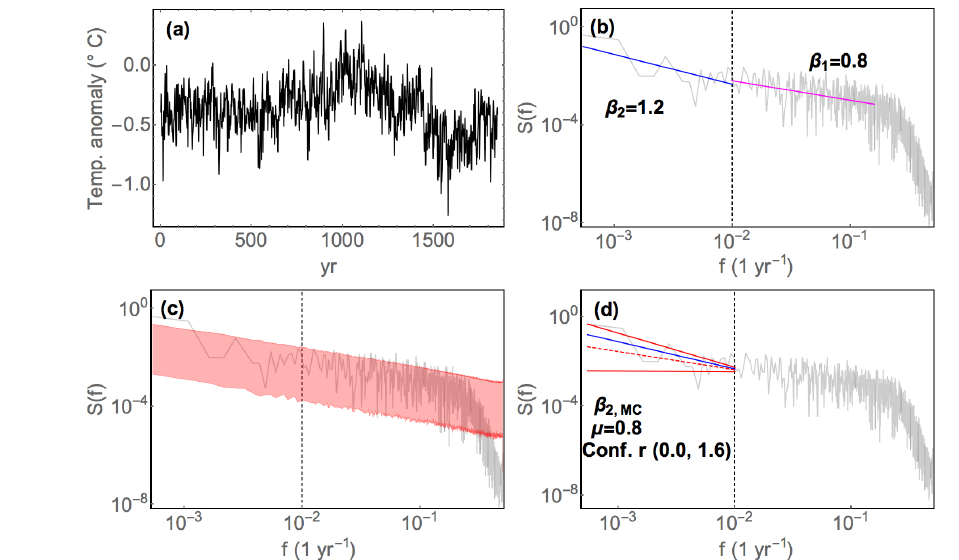
Figure 5. (a) The Moberg et al. (2005) reconstructed temperature for the Northern Hemisphere. (b) Estimated values of β 1 and β 2 . (c) 95% confidence range for periodograms in the Monte Carlo study. (d) 95% confidence range for estimates of β 2